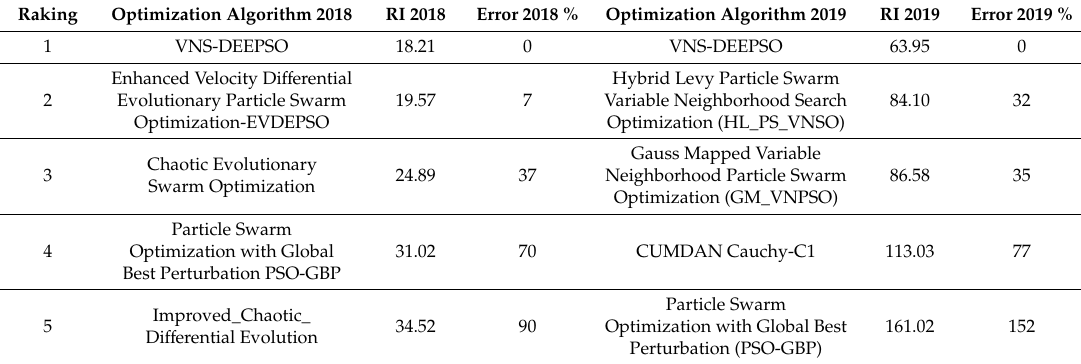
Table 7. Results of the